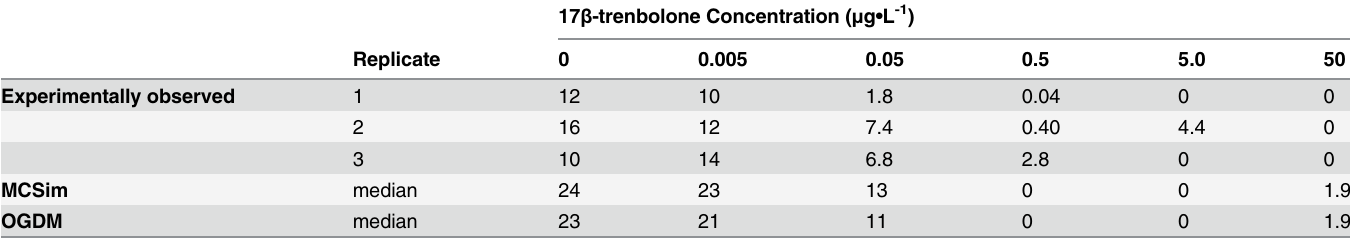
Table 1. Average fecundity (eggs (cid:129) female -1 (cid:129) day -1 ) of 17 β -trenbolone exposed fathead minnows: experimentally observed values, and median pre- dictions from the OGDM and MCSim oocyte growth dynamics